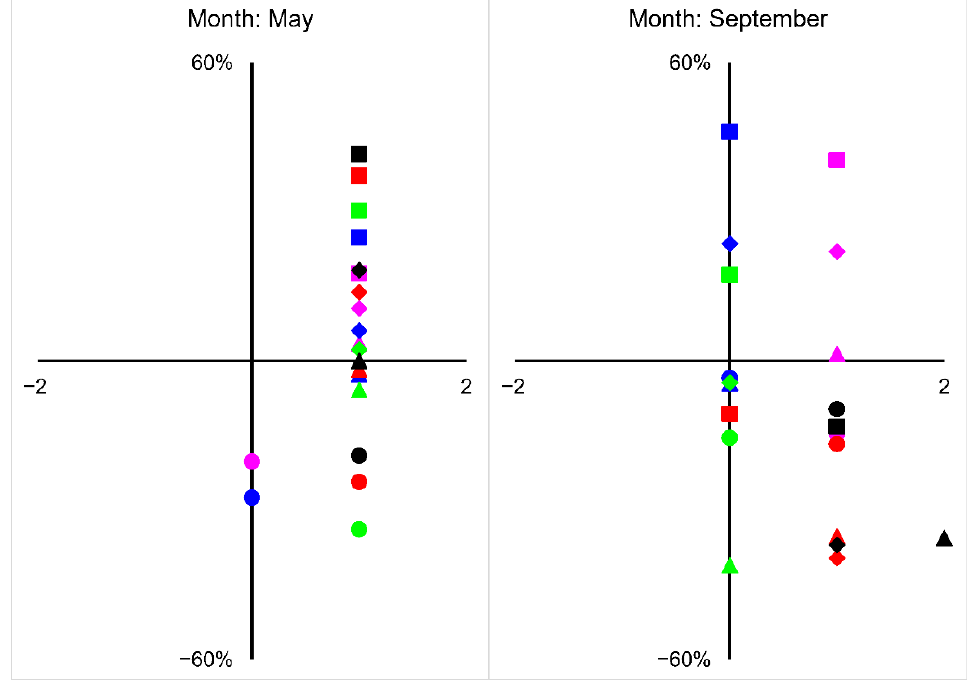
Figure 13. Quadrant chart of the four mitigation plans for design storms with return period, 5-year (black), 10-year (red), 25-year (green), 50-year (blue), and 100-year (magenta). Circles represent “Revegetation (All)”; diamonds represent “Gabion (All)”; triangles represent “Revegetation + Gabion (All)”; and squares represent “Revegetation + Gabion (Selected)”.